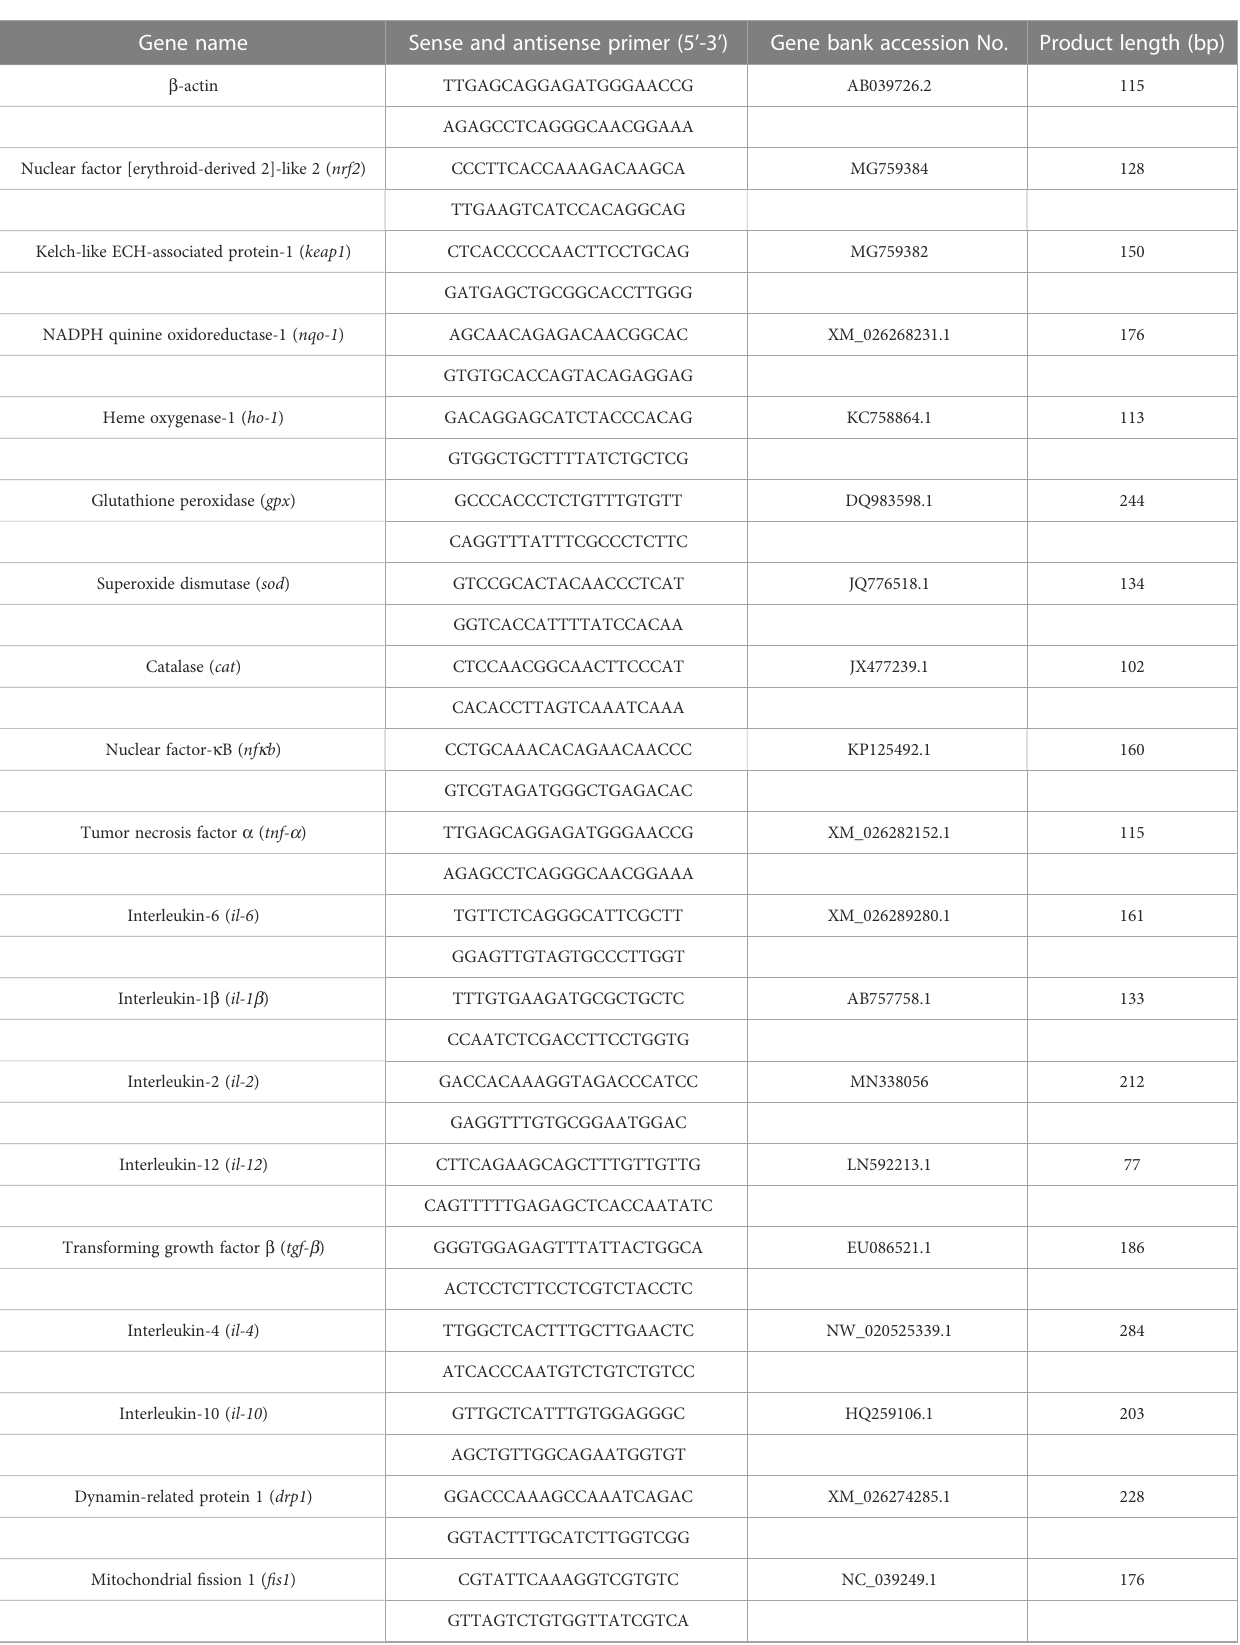
TABLE 2 Sequences of primers used for quantitative real-time PCR analysis in gibel